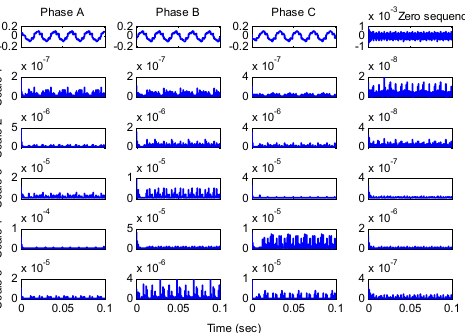
Figure 8. In the case of normal conditions, DWT of differential currents from scale 1 to scale 5.